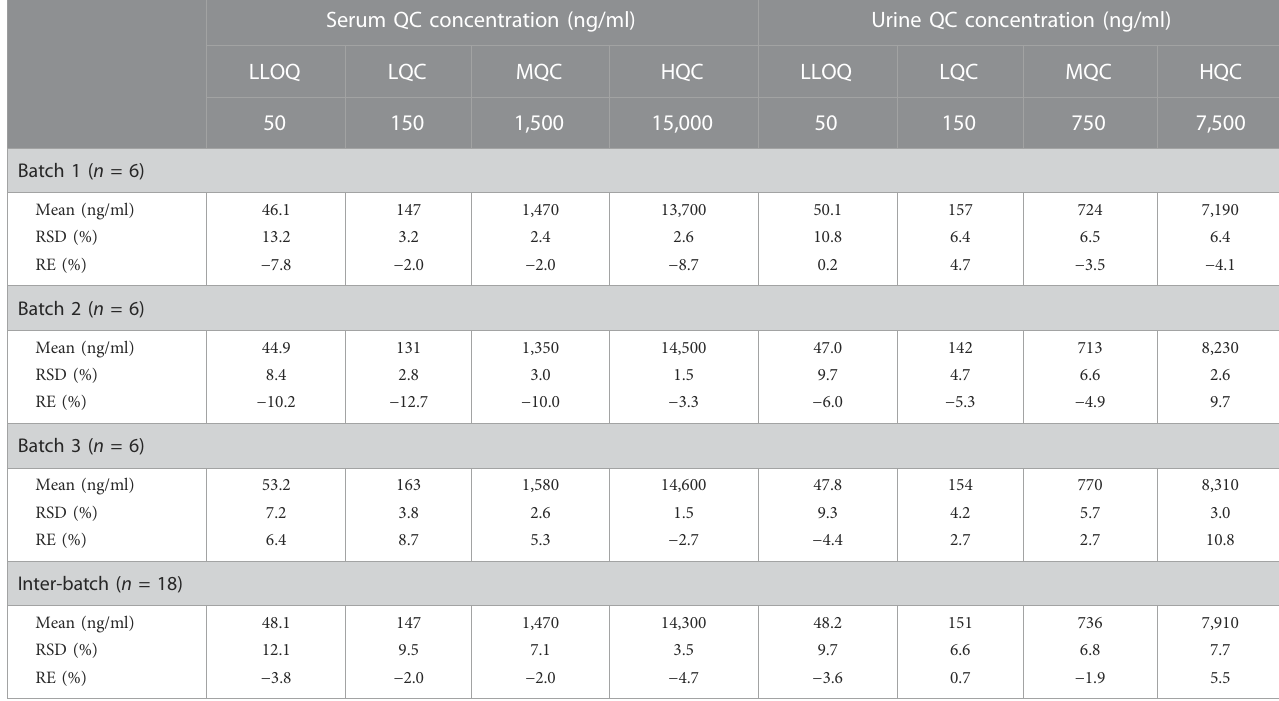
TABLE 1 Inter- and intra-batch accuracy and precision of etimicin in human samples of serum and urine. Serum QC concentration (ng/ml)